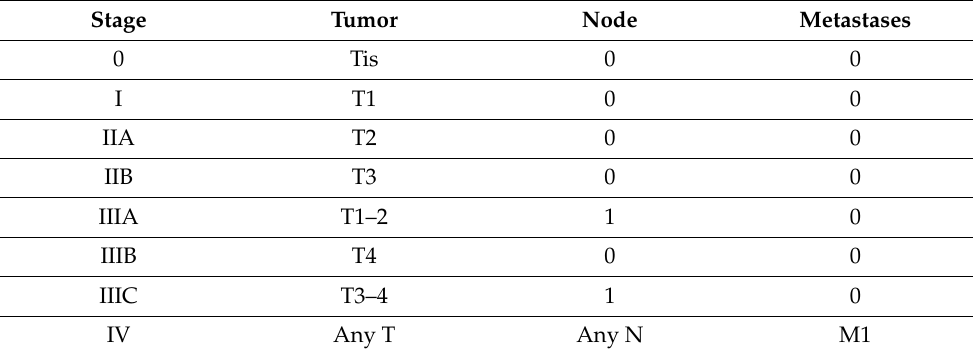
Table 2. Stage of anal cancer as per tumor nodal and metastasis